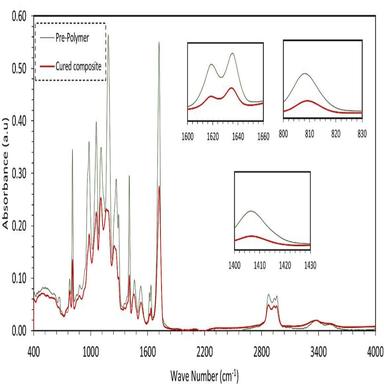
FTIR spectrum of the pre-polymer and cured composite. Graph inserts showing peak reduction indicating monomer conversion.